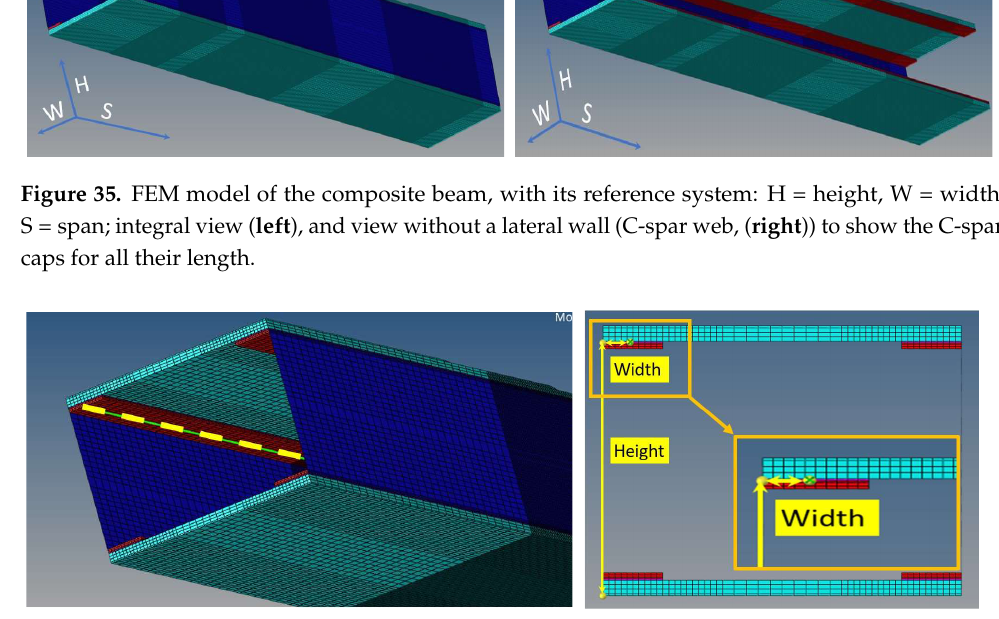
Figure 36. Position of digital optical fiber ( left ) and reference coordinates (height, width) ( right ).